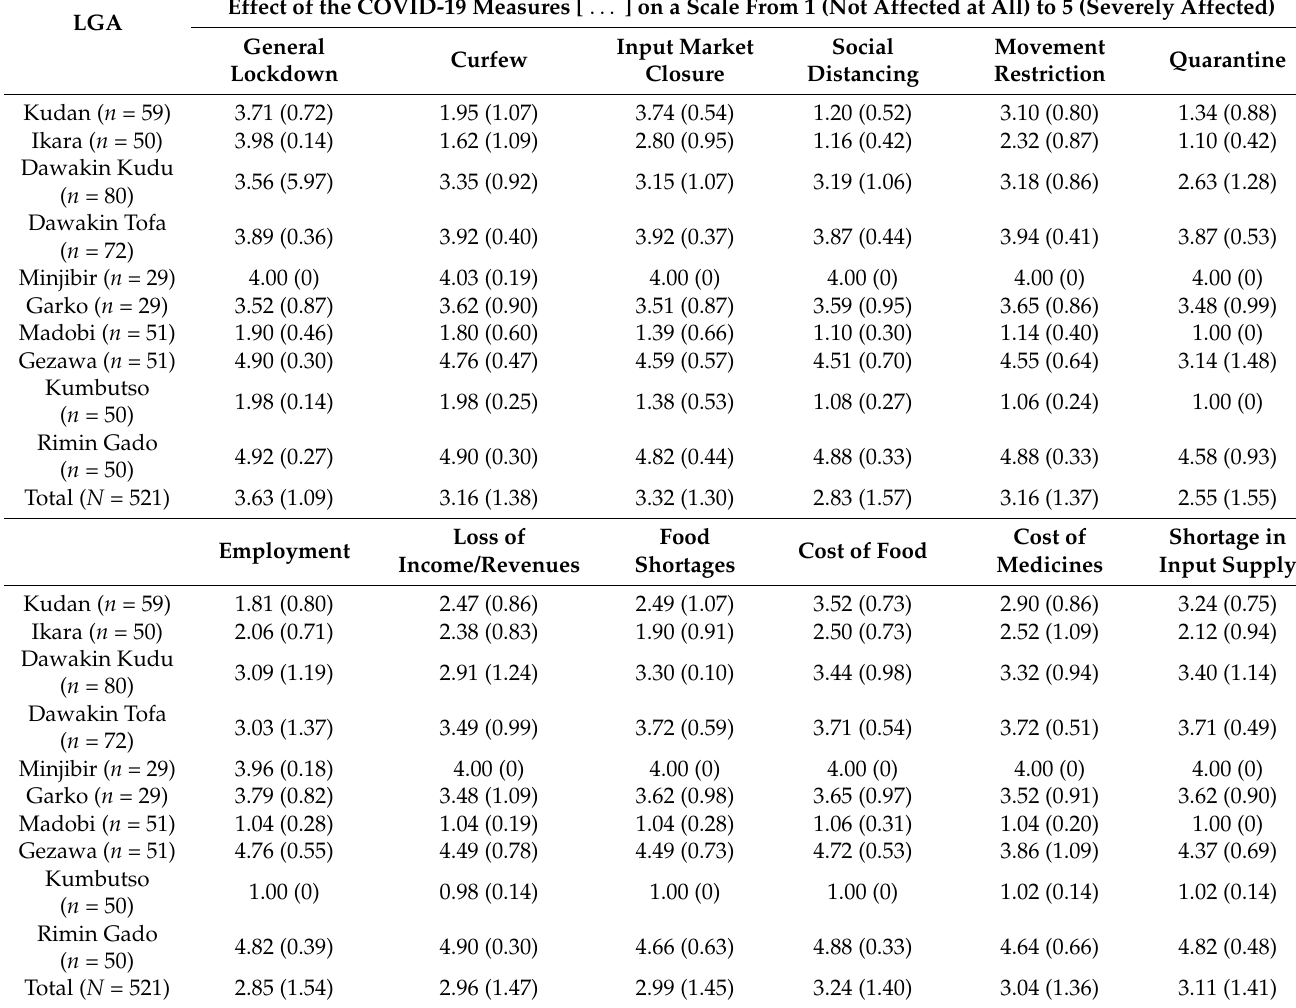
Table 4. Respondents’ perceptions on the effects of the COVID-19